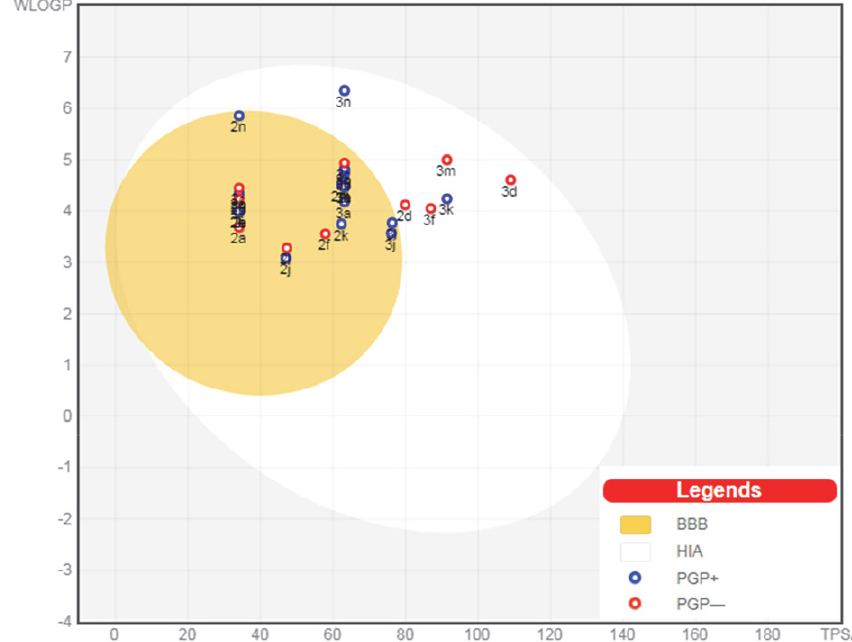
Figure 4 . The BOILED-Egg predictive models of all